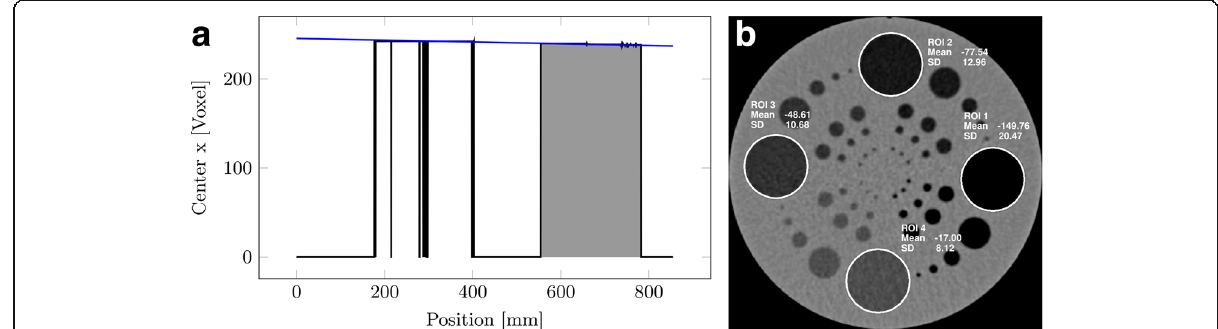
Fig. 4 a Example of a plot of detected x -coordinates of the object centre for valid segments (black line), plotted over slice position, for a sediment core. The blue line indicating core position in x was fit to the largest segment (grey area). b Example axial CT image of the phantom used for evaluation of the algorithm, showing the placement of regions of interest (ROIs) in the low-contrast section of the phantom